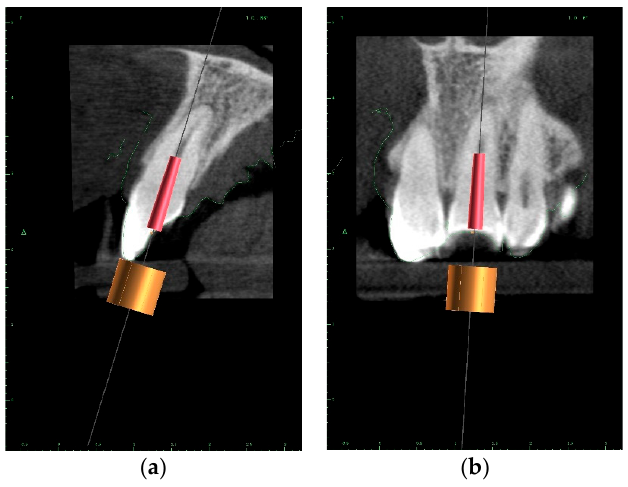
Figure 11. CBCT image presenting a scheduled virtual implant: endodontic access path in ( a ) sagittal view and ( b ) coronal view. The volume of the preserved dentin around the access path is shown.